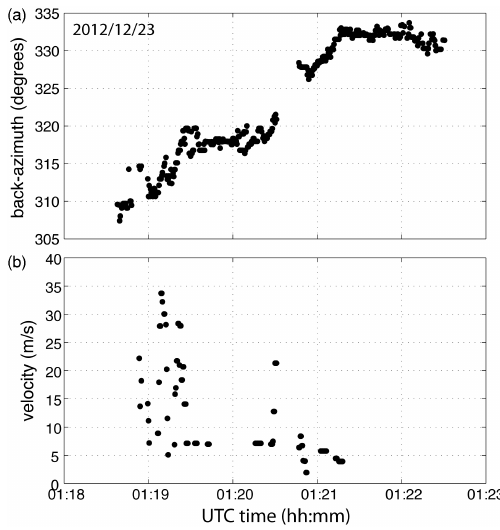
Figure 5. Back azimuth of the 23 December 2012 Grosstal avalanche (a) and instantaneous avalanche front velocity (b) derived from the infrasound array analysis.